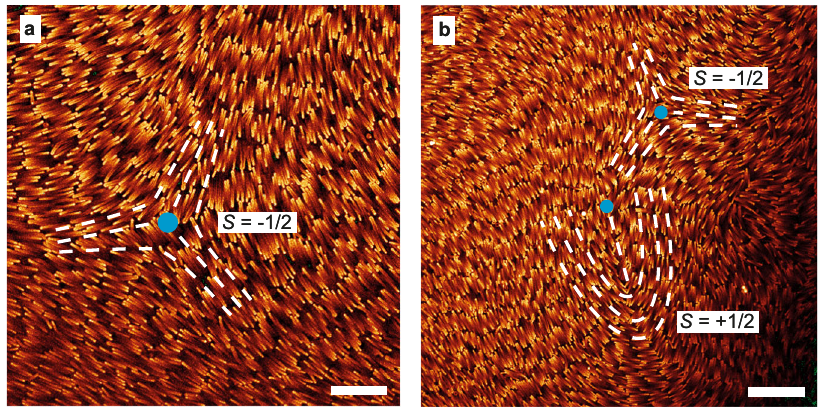
Fig. 4 | Fluorescence confocal microscopy imagesofdefects in nematic phases ofBSR. Bluedotsindicatethepositionofthedefectanddashedwhitelinesgivean indication of the direction of the nematic director fi eld. a Line defect with